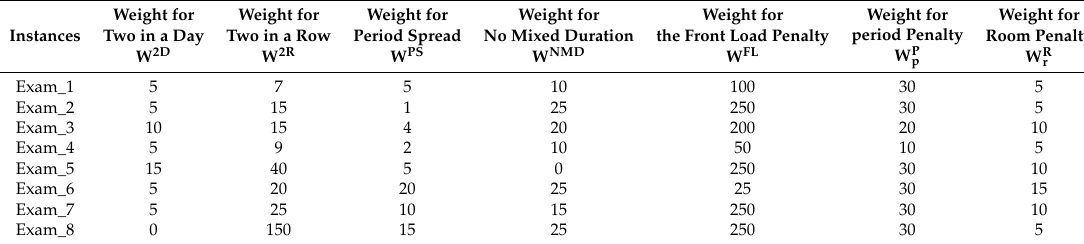
Table 3. Weights of the ITC2007 exam